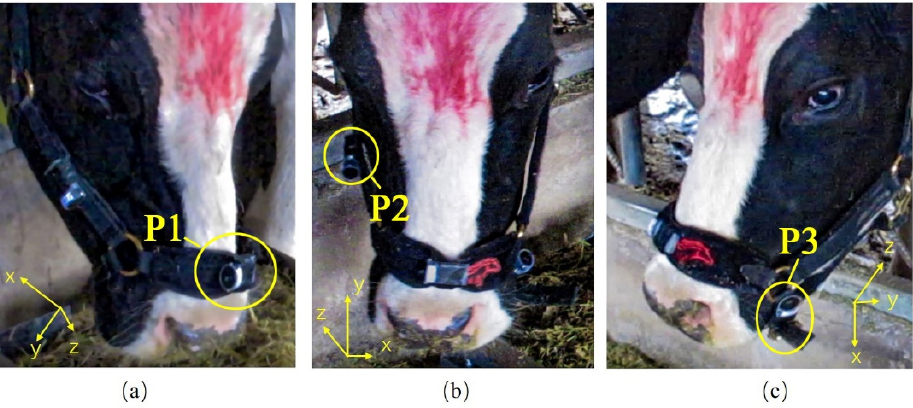
Figure 1. The orientations of the X -, Y -, and Z -axes when the triaxial accelerometers were at the positions of P1 ( a ), P2 ( b ), and P3 ( c ).